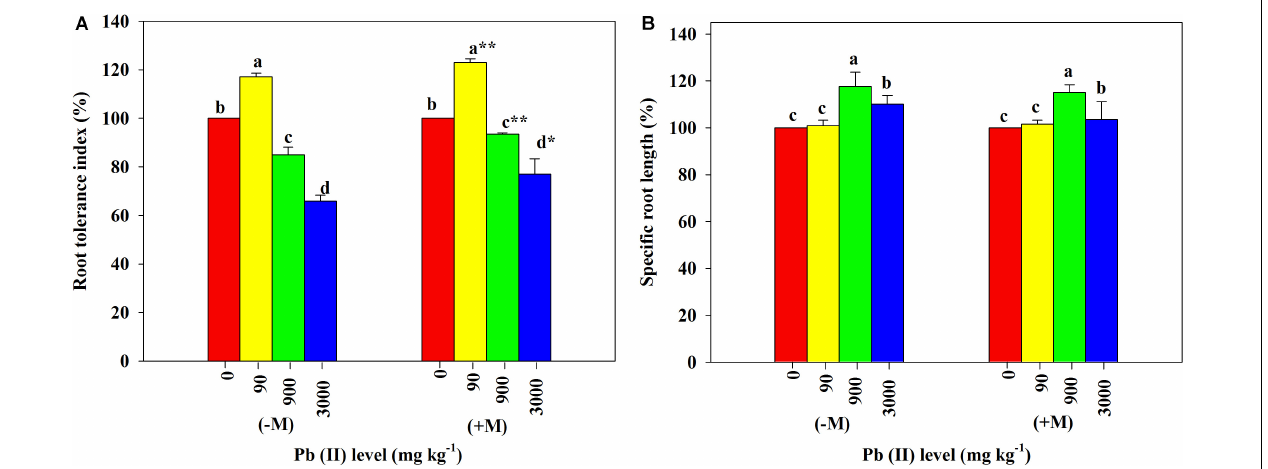
FIGURE 5 | Relative changes in root tolerance index and specific root length of Robinia pseudoacacia seedlings grown with or without Funneliformis mosseae and subjected to different Pb levels for 4 months. (A) Root tolerance index. (B) Specific root length. Shown are means ± SD ( n = 3). Asterisks indicate significant differences between inoculated and non-inoculated seedlings within each Pb treatment ( ∗ P < 0.05, ∗∗ P < 0.01; t -test). Different lowercase letters indicate significant differences among different Pb levels within inoculated or non-inoculated treatment ( P < 0.05; ANOVA with post hoc